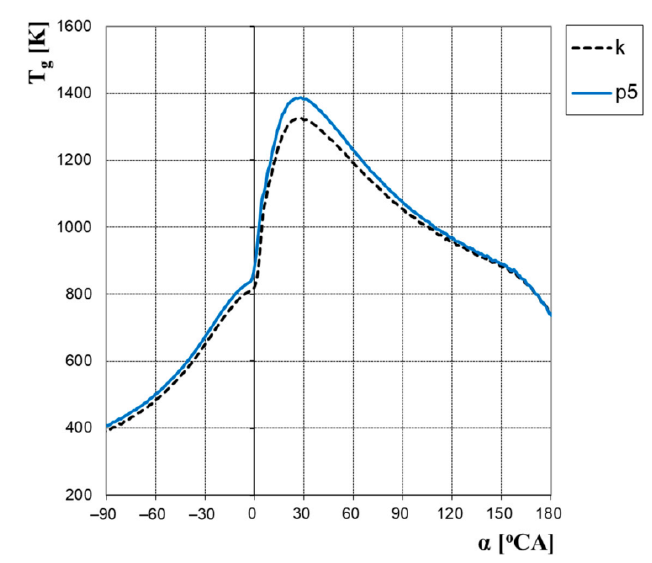
Figure 10. The course of the rate of heat ∆ X i / ∆ α release, the heat absorbed by the exhaust gas X i , and the average temperature T g : ET = 15 [ N · m ] of the exhaust gas ( n = 2000 [ rpm ]